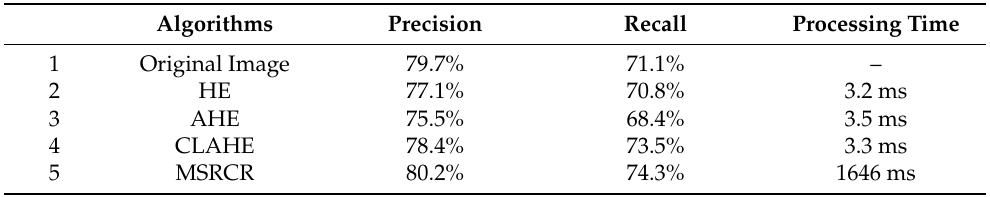
Table 1. Comparison of detection performance using YOLOv5s for different image enhancement al-